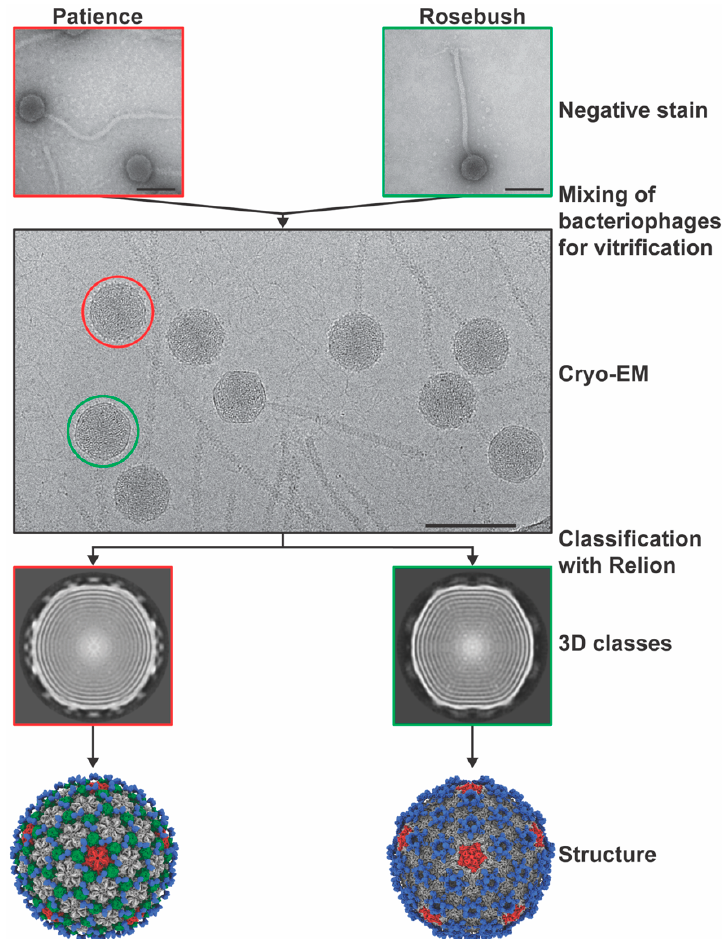
Figure 2. Multiplexing bacteriophage samples. Diagram showing the basic method by which the bacteriophages were multiplexed on a single cryo-EM grid and used for data analysis. Scale bar is 100 nm.